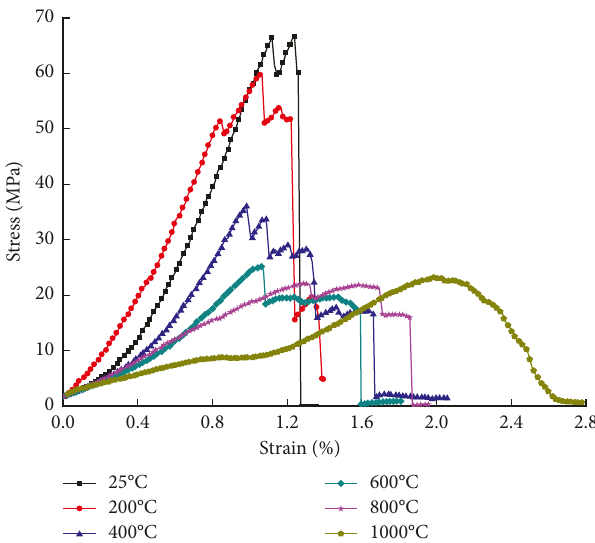
Figure 3: Stress-strain curves of granite under uniaxial com- pression at high temperatures.